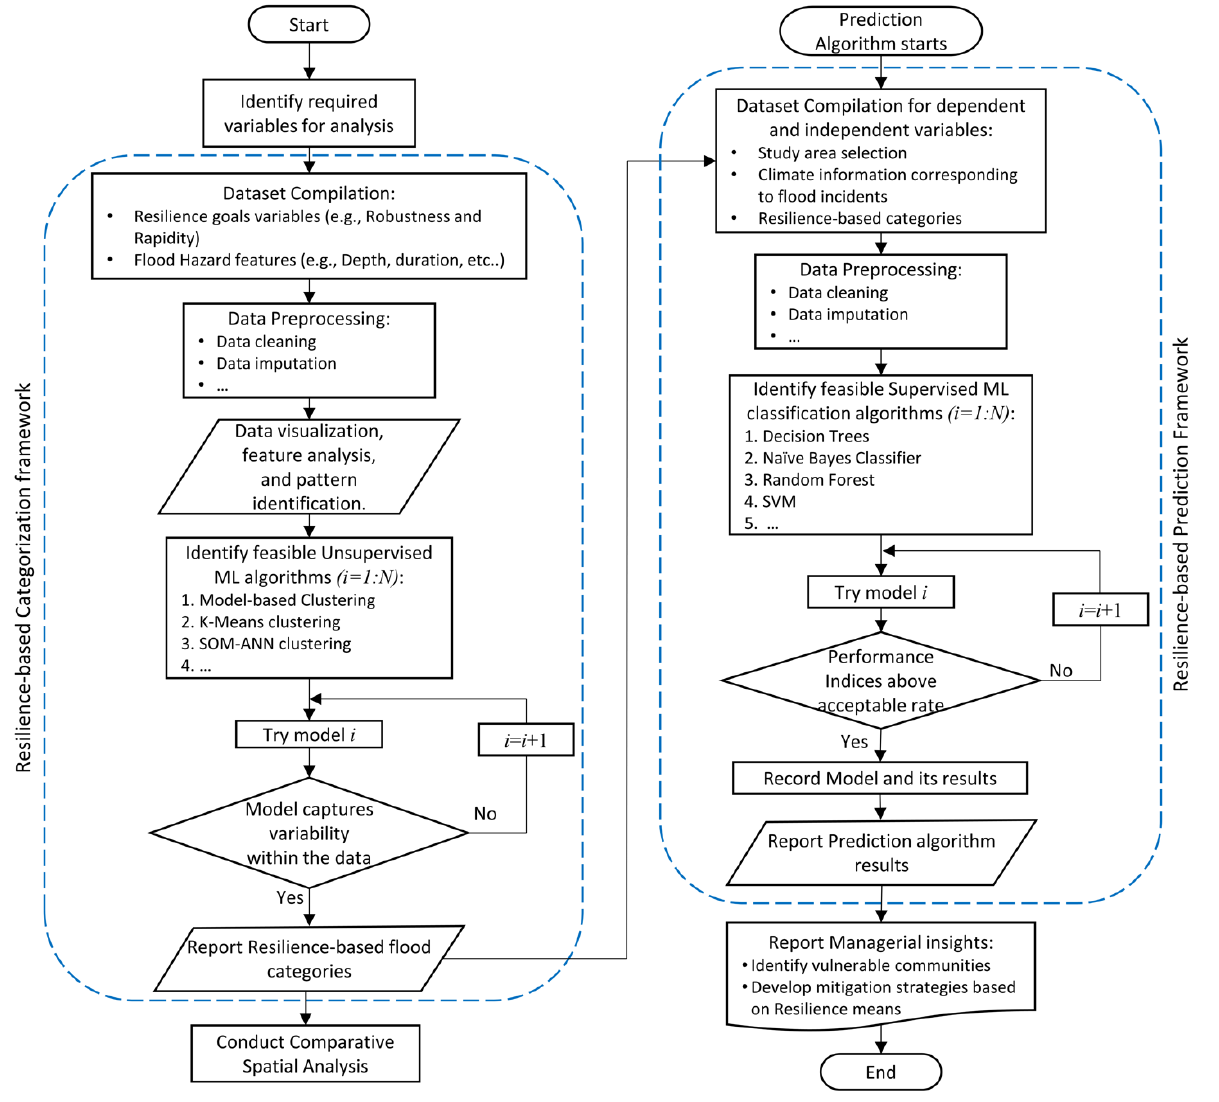
Figure 1. Multi-stage framework layout for resilience-based flood categorization and